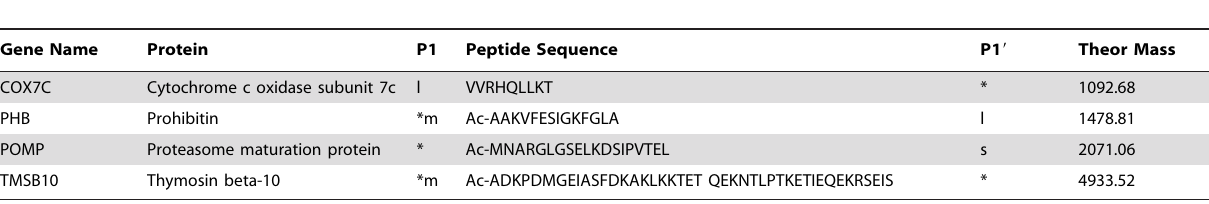
Abbreviations are defined in Table 1.